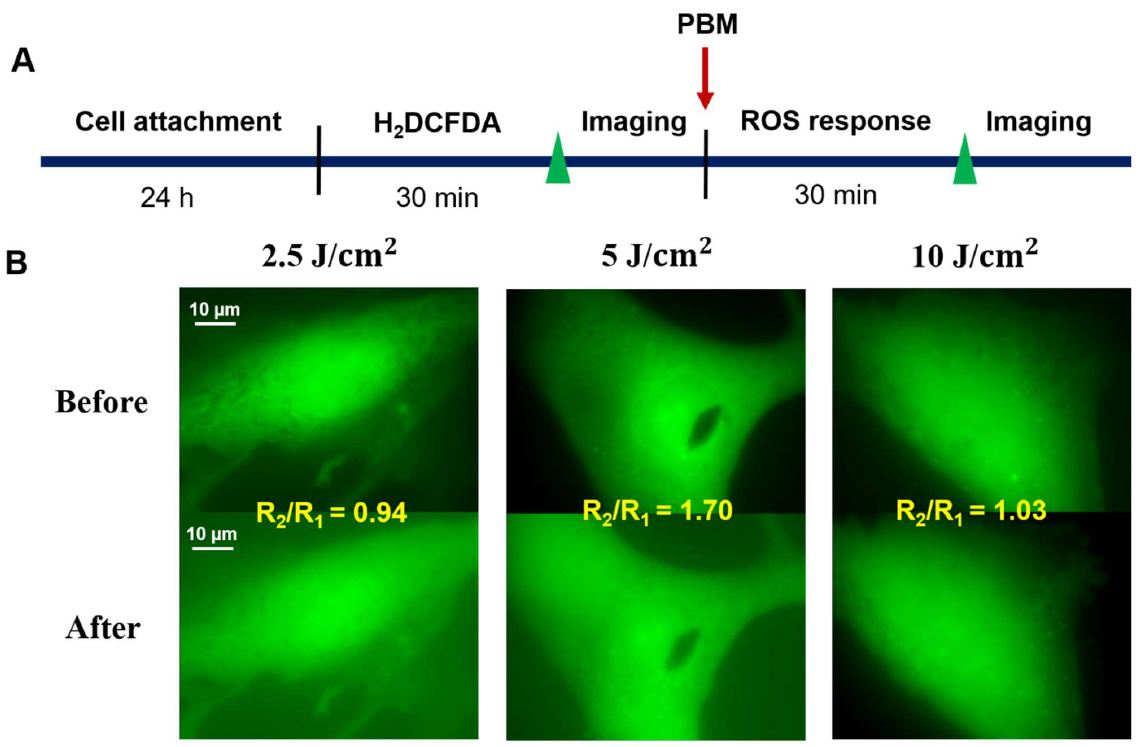
Figure 7. ( A ) Experimental procedures in investigating the ROS production in the irradiated-hADSCs (Passage 10) ( B ) ROS marker fluorescence microscopy pictures were acquired in the hADSCs after 30 min. These cells were spontaneously picked and captured by an EMCCD camera following various time points of PBM at fluences of 2.5, 5, and 10 J/cm 2 . The scale bar denotes a distance of 10 µm.